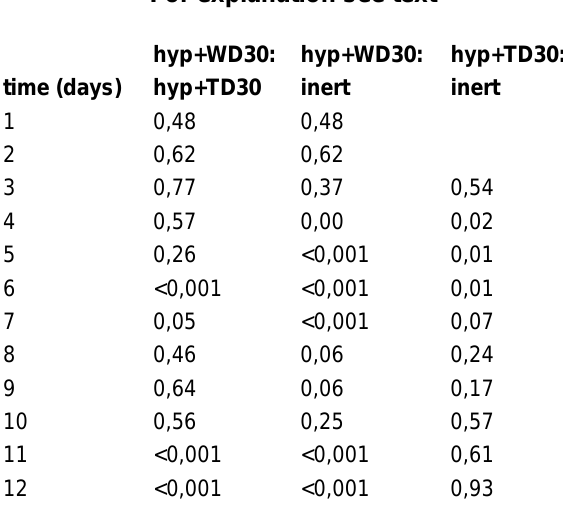
For explanation see